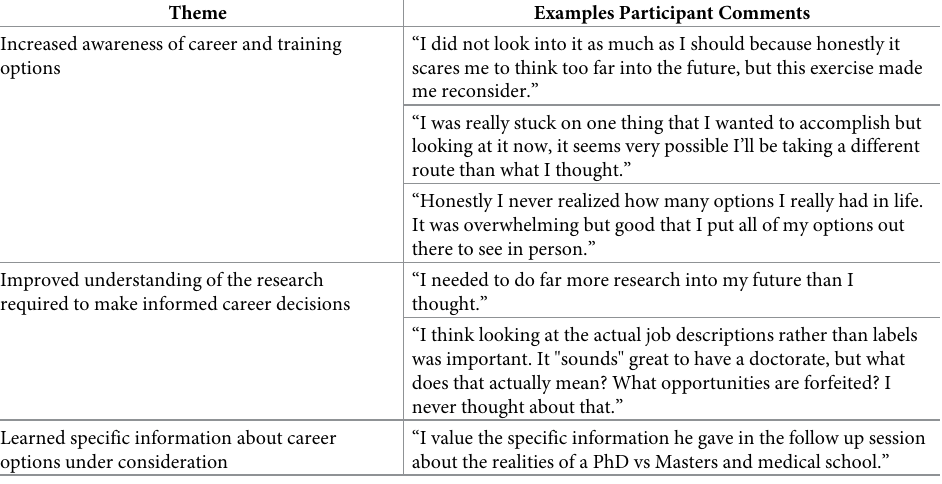
Table 2. Examples comments made by participants regarding the value of the Future Life Map